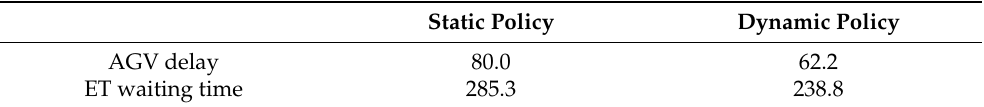
Table 5. Performance comparison of the two